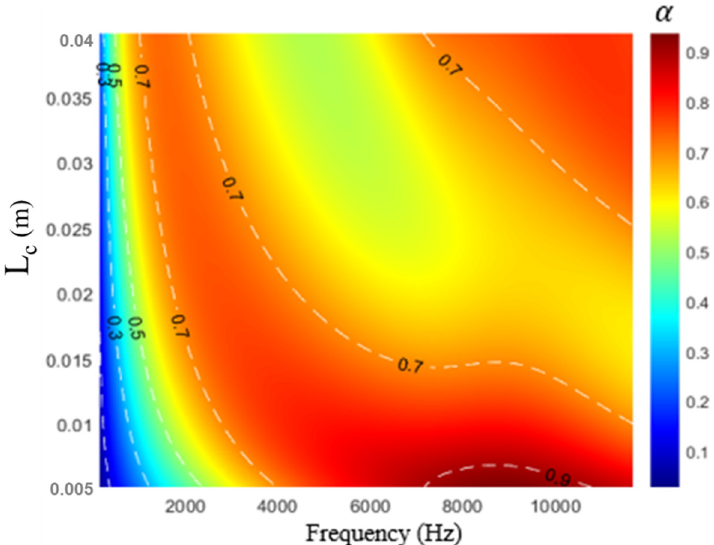
Figure 9. Influence of cavity thickness on contour of sound absorption.